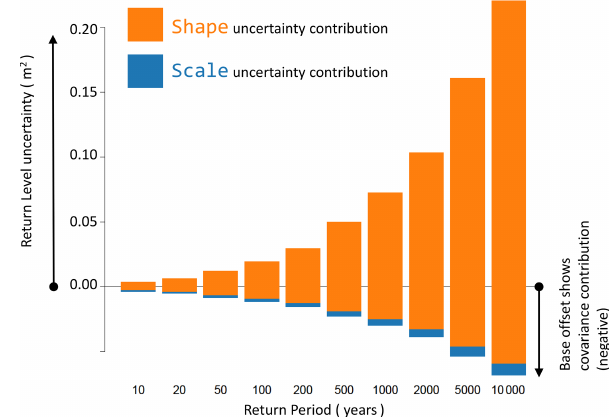
Figure C1. Short record lengths lead to noisy MLE shape- parameter estimates. (a) Shape parameter of GEV fit to tide gauge data against the number of annual maxima fitted (blue dots, one for each tide gauge) and shape parameter of GEV fit to model data (orange crosses, one for each tide gauge, all 483 years). Note that the range of fitted shape parameters decreases (“tapers”) as record length increases. (b) Model data for each port are cut down to a (random) sub-sample having the same length as the observational record at that port and then fitted in the same way as the obser- vations. A similar tapering pattern emerges. Panel (c) as (b) but a different random sub-sample. Also shown (grey) is the 5th to 95th percentile range from 100 such sub-samples at each port. (d) Sim- ilar to (a–c) but using pseudo-random variates drawn from a GEV distribution with scale and shape parameter which are typical of the values found around the UK (0.12m and − 0 . 06 respectively). Sample size varies from 5 to 500, as shown by the logarithmically scaled x axis. For each sample, GEV parameters are fitted by maxi- mum likelihood estimation. For each sample size, 2000 samples are drawn and the 5th to 95th percentiles of the fitted shape parameters are shown by the grey bar. The dashed green line shows a shape of − 0 . 06. The 5th to 95th percentile intervals for sample sizes 5, 7, and 10 exceed the Y -axis limits.